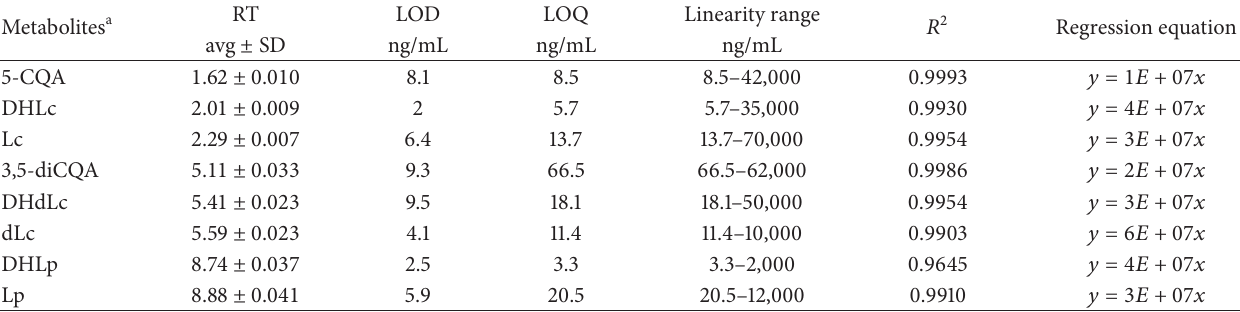
Table 3: Retention time (RT), limit of detection (LOD) and of quantitation (LOQ), linearity range, determination coefficient ( 𝑅 2 ), and regression equation of metabolites